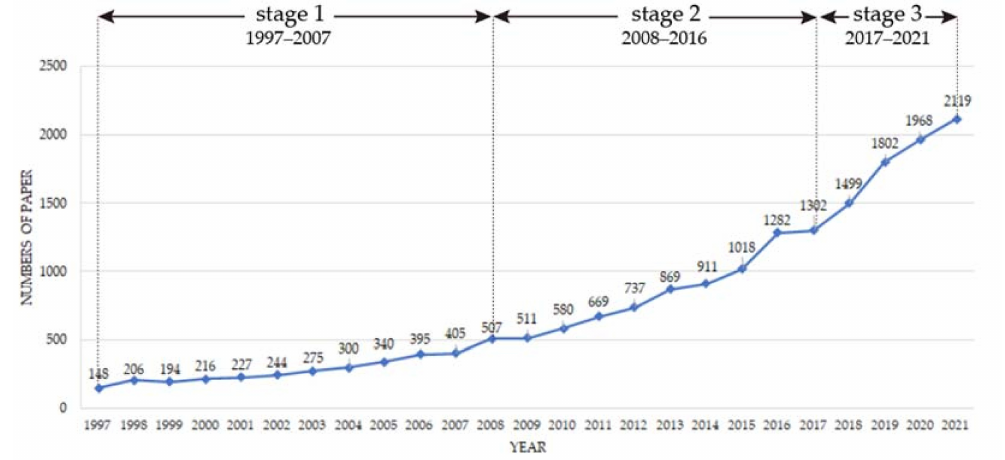
Figure 2. Distribution of annual publication outputs in the ZCC field from 1997 to